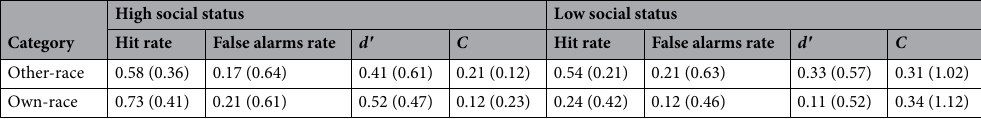
Table 2. Average hit rate, misrepresentation rate, d ′ , and C in Study 2. The numbers outside the brackets in the table are the means, and the numbers inside the brackets are the standard deviations.